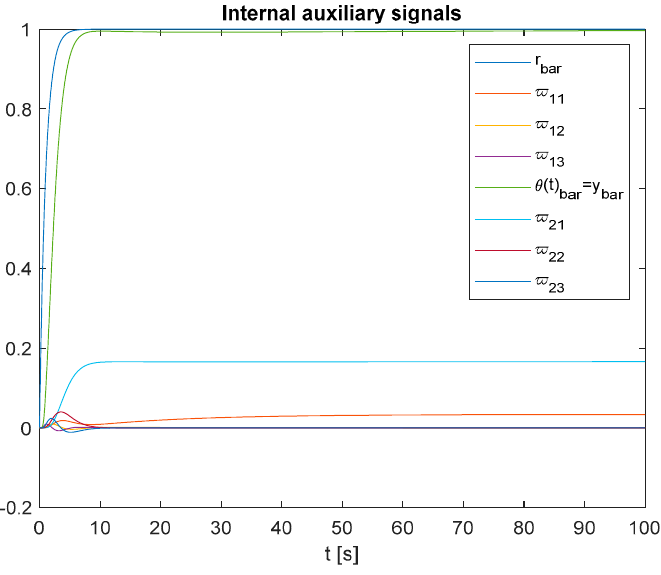
Figure 18. Auxiliary signals 𝜔(cid:3365) (all bounded).